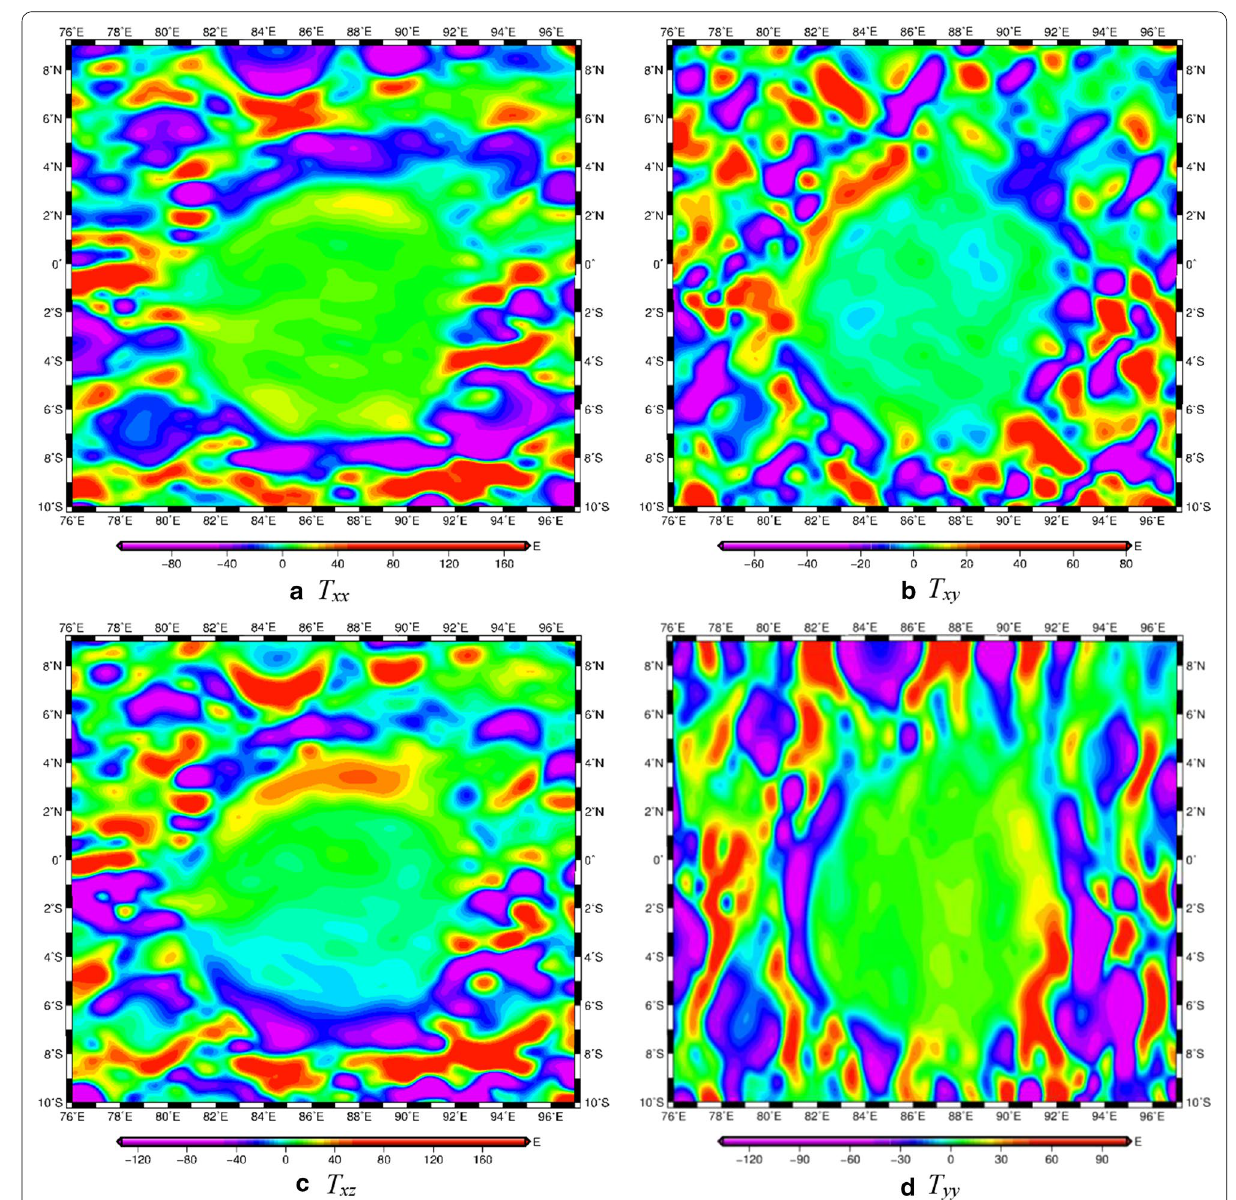
Fig. 14 Lunar GGT datasets derived from GL1500E, a , b , c and d are T xx , T xy , T xz and T yy component of the lunar GGT,